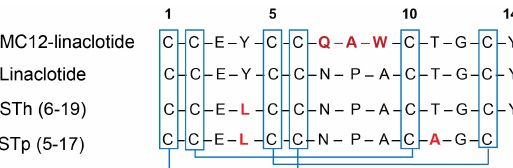
Figure 1. Sequences of MC-12-linaclotide, linaclotide, STh (6-19) and STp (5-17), linaclotide-related peptides. The differences in sequences are highlighted in red. The disulfide bonds are highlighted in blue.